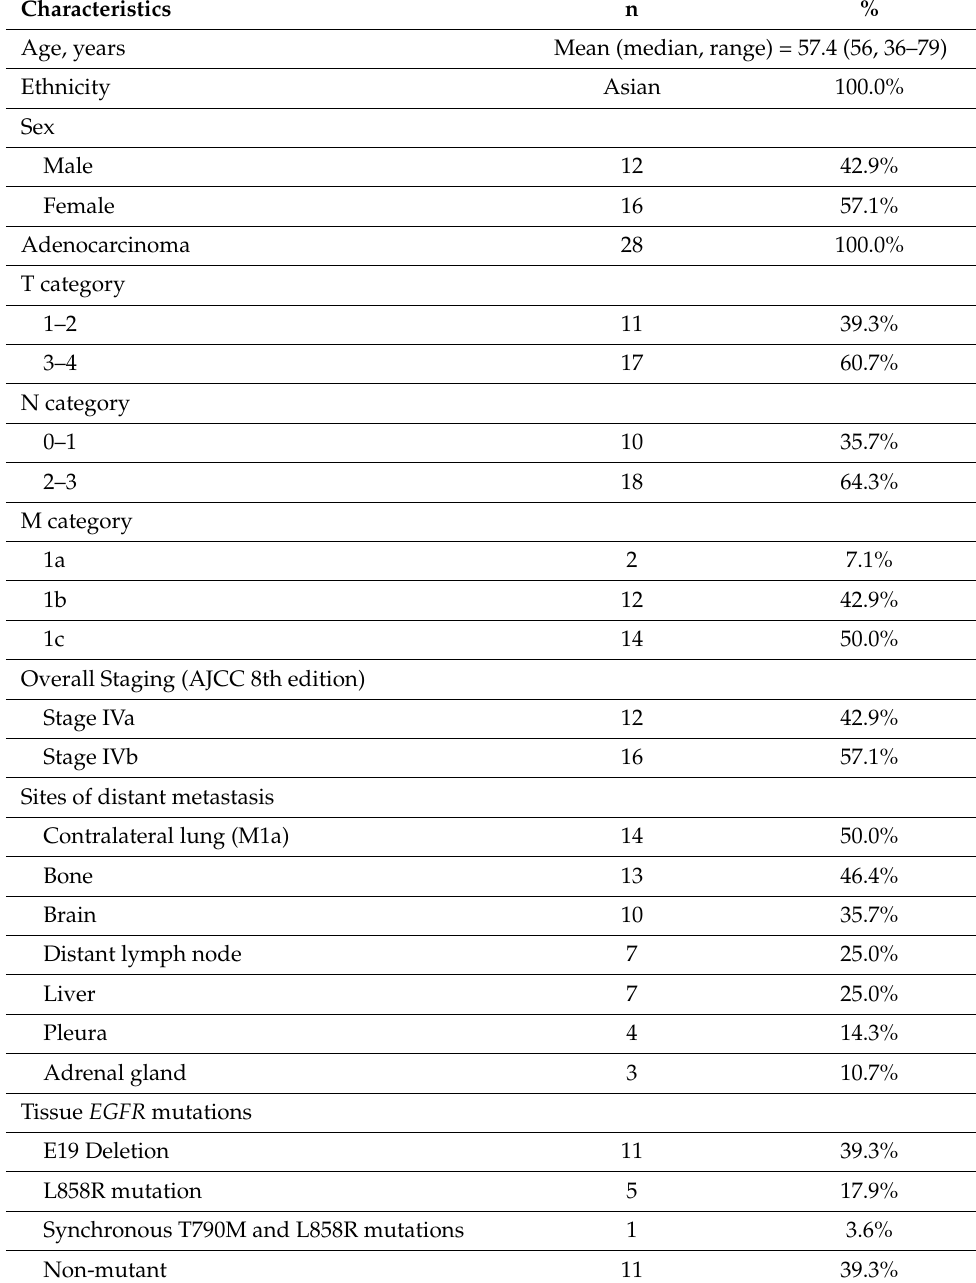
Table 1. Basic characteristics of enrolled patients and samples (n =